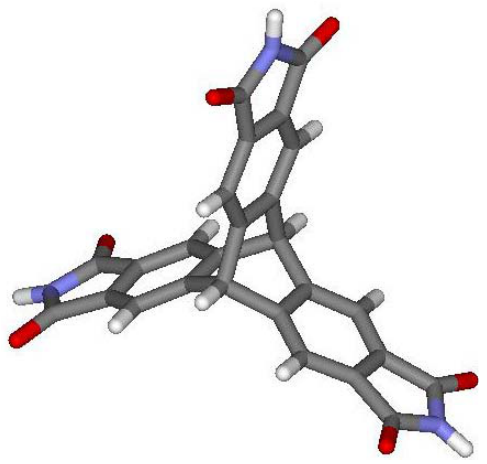
Figure 2. Crystal structure and crystal packing of molecule 7